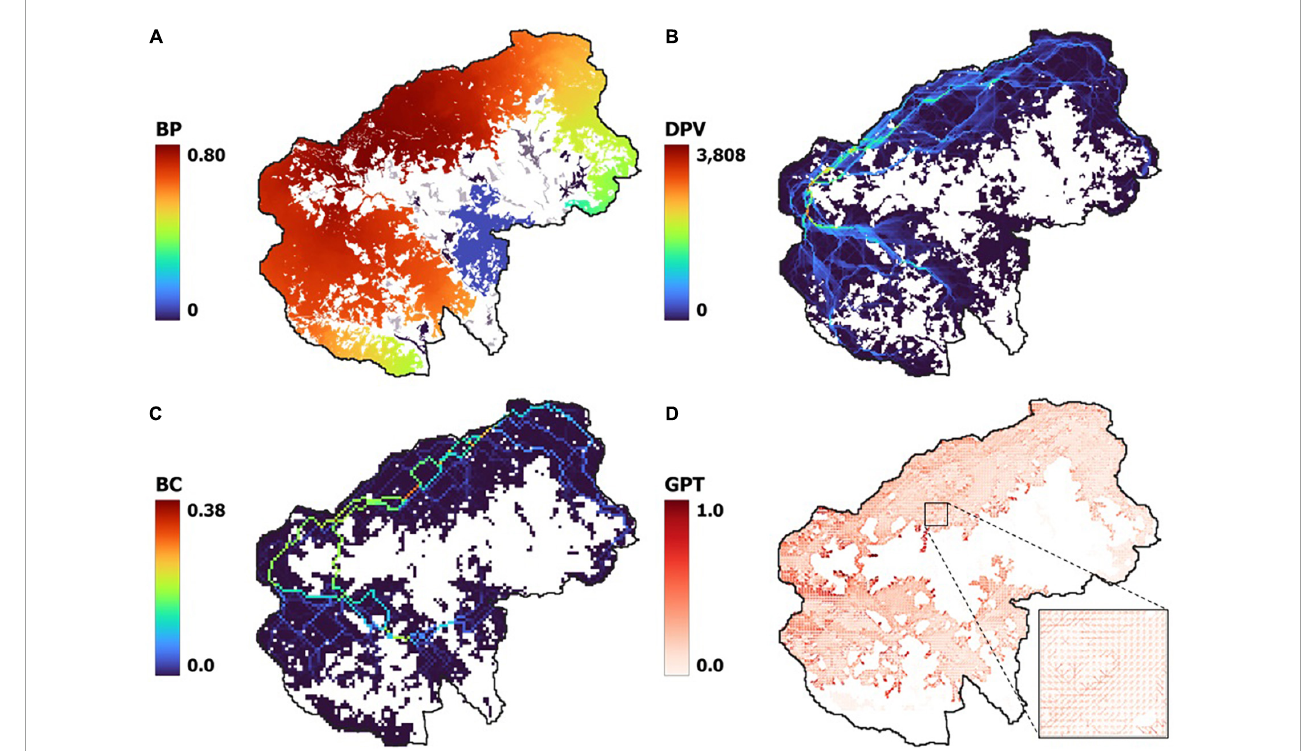
FIGURE5 Examples of metrics that can be obtained from 1,000 stochastic simulations with various ignition points and weather scenarios. (A) Burn probability; (B) downstream protection value; (C) betweenness centrality; (D) global propagation